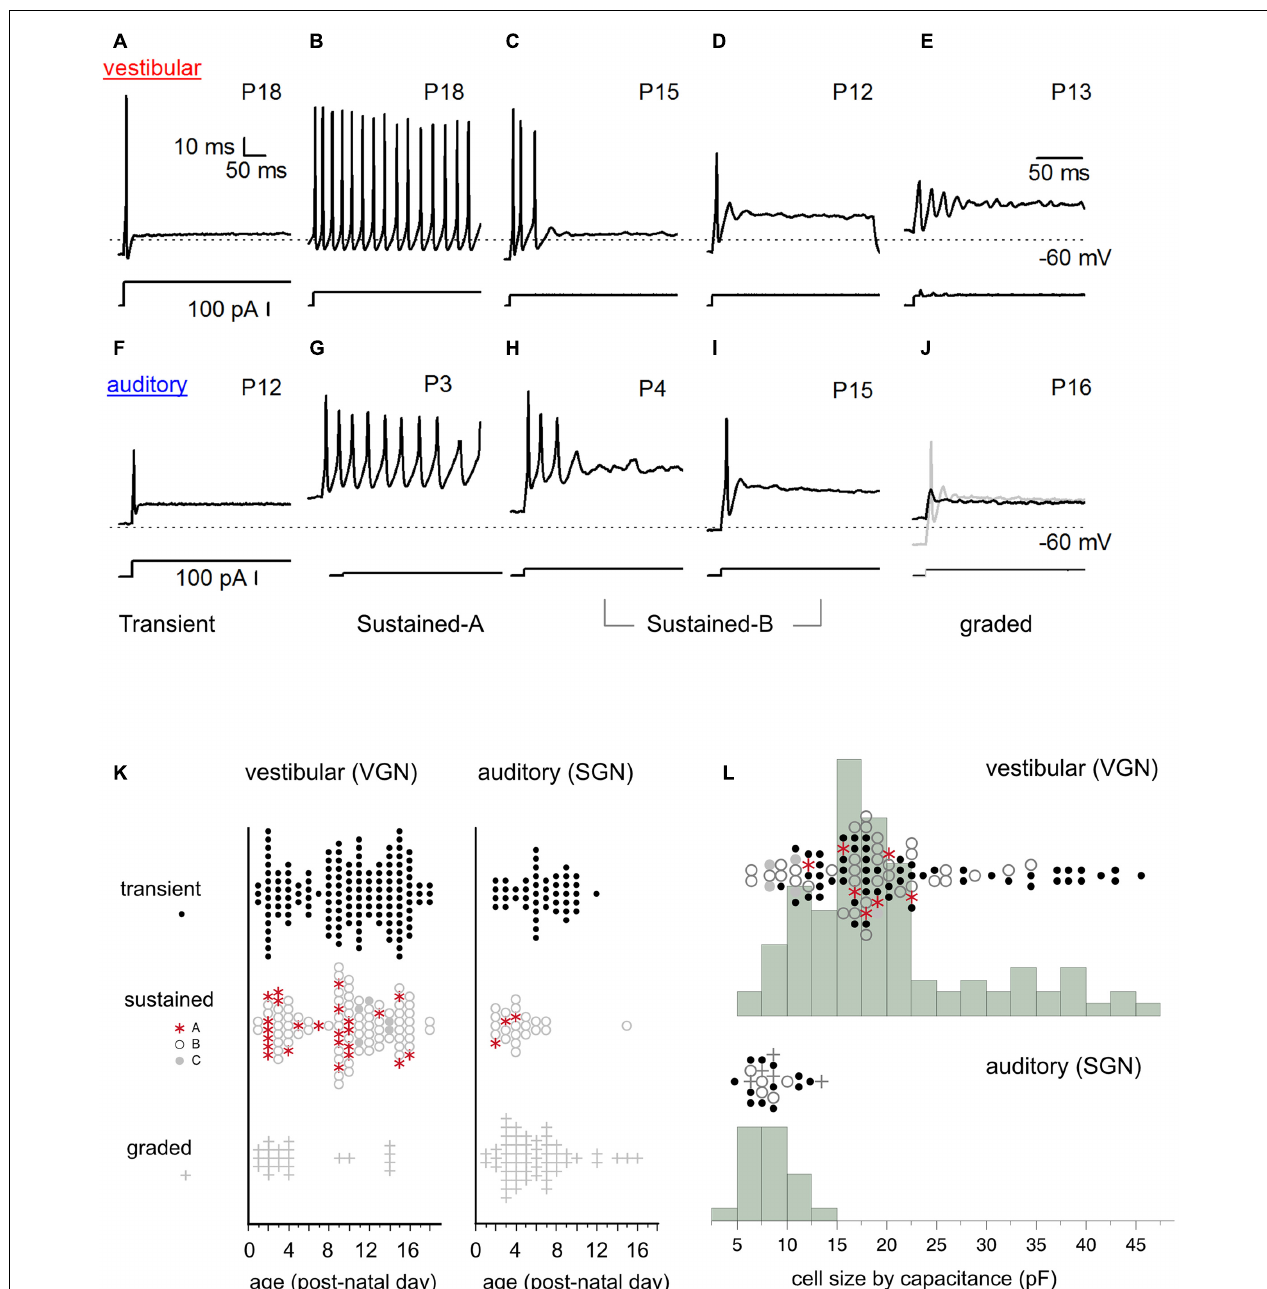
FIGURE 2 | Diversity of in vitro firing patterns in response to step current injection. (A–E) Firing patterns in five example vestibular ganglion neurons. Transient-spiking (A) , sustained-A spiking (B) , sustained-B spiking (C,D) . Non-spiking/graded responses (E) . Dashed line indicates –60 mV. Traces below the firing patterns indicate stimulus. (F–J) Similar range of firing patterns in five example spiral ganglion neurons (auditory). Transient-spiking (F) , sustained-A spiking (G) , sustained-B spiking (H,I) . Non-spiking/graded response (black trace). (J) Spiking is induced by injecting a –10 pA hyperpolarizing current before applying the current step (gray trace) (J) . (K) Prevalence of firing patterns as a function of postnatal age in VGN (left) and SGN (right). (L) Distribution of somatic cell size in vestibular and spiral ganglion. Cell capacitance values were available in fewer cells than shown in (K) . In (K,L) , symbols indicate firing patterns as follows: Transient (black dots), sustained-A (red asterisks), sustained-B (open gray circles), non-spiking plus graded (plus sign).